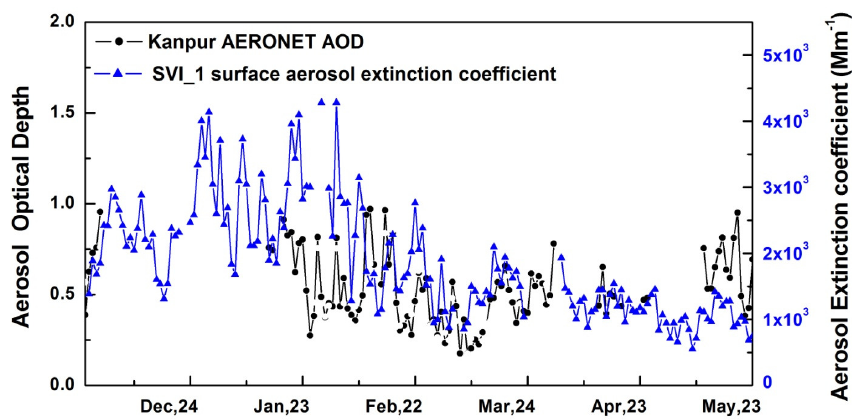
Fig. 2. Comparison of surface aerosol extinction coefficient at Surya village (SVI 1) with the column AOD measured by AERONET at neighboring urban center,